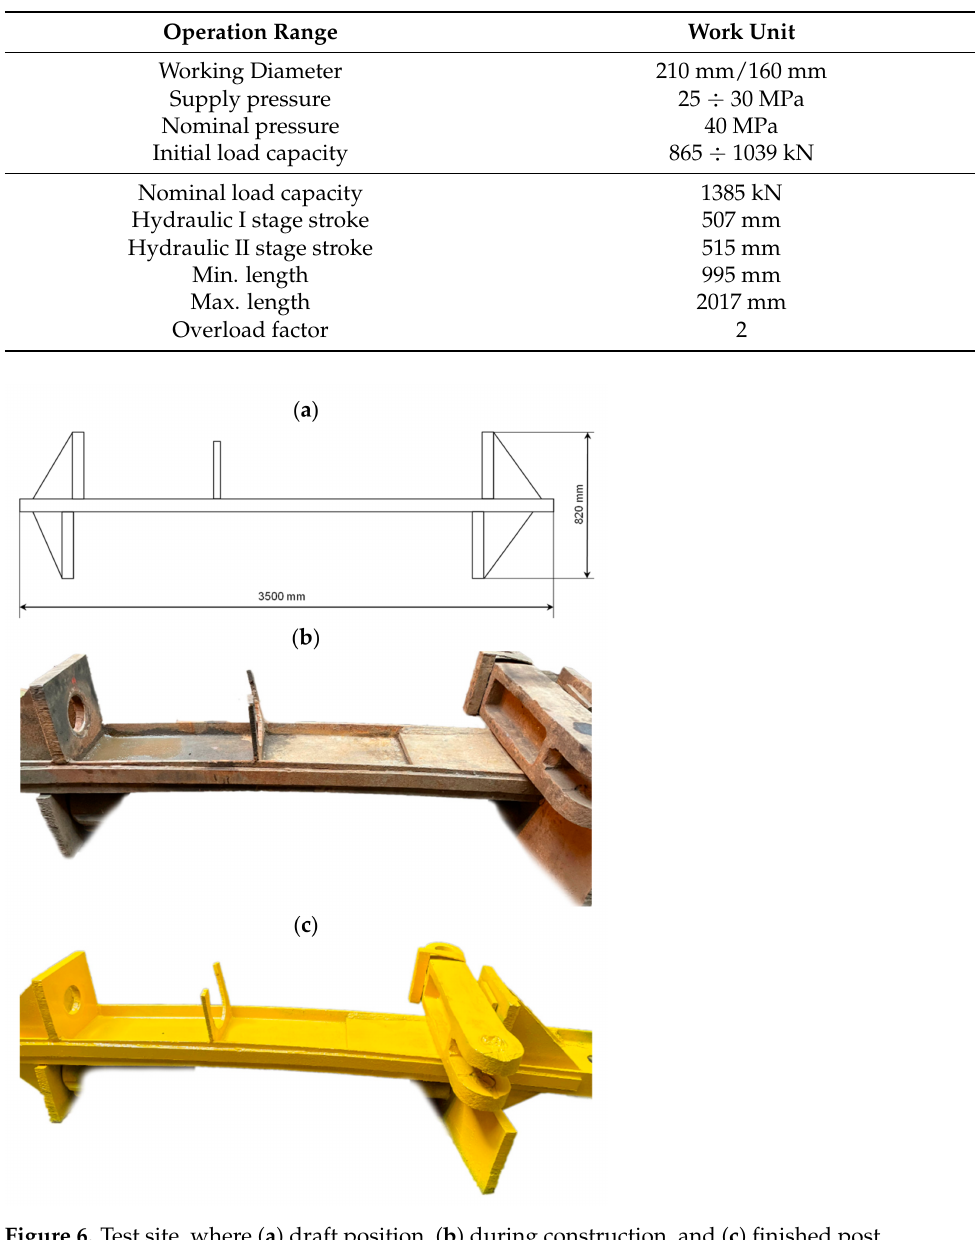
Table 2. Technical characteristics of the hydraulic prop of the powered roof support.